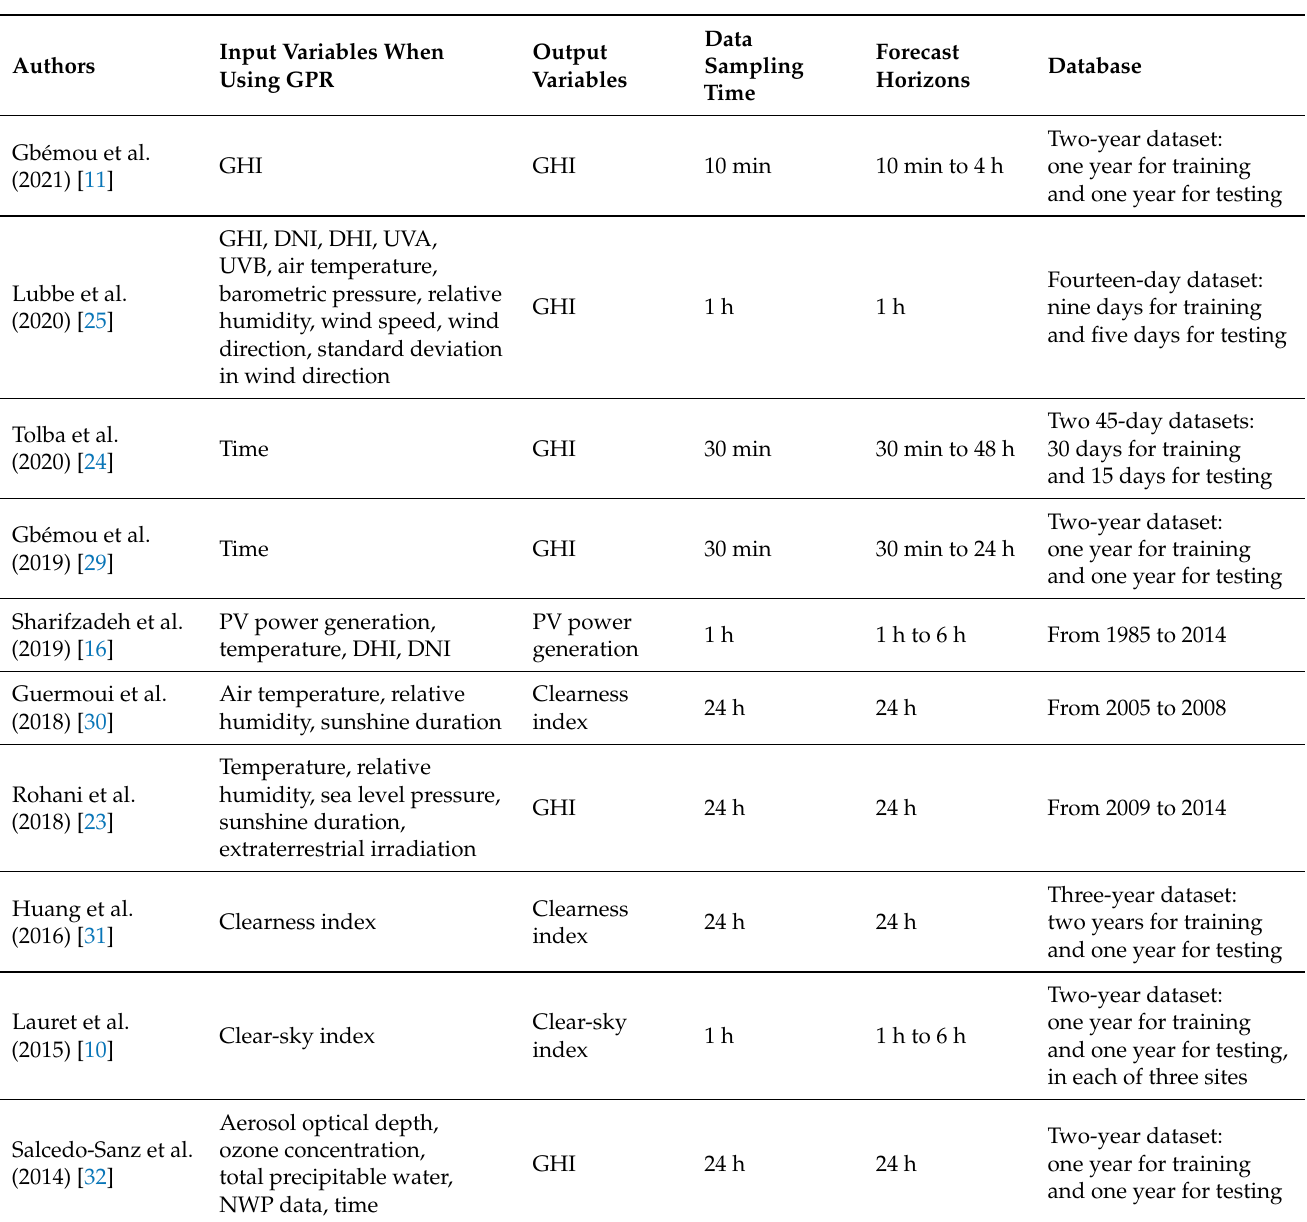
Table 1. Main recent studies including Gaussian process regression models. For the meaning of abbreviations, see the end of the